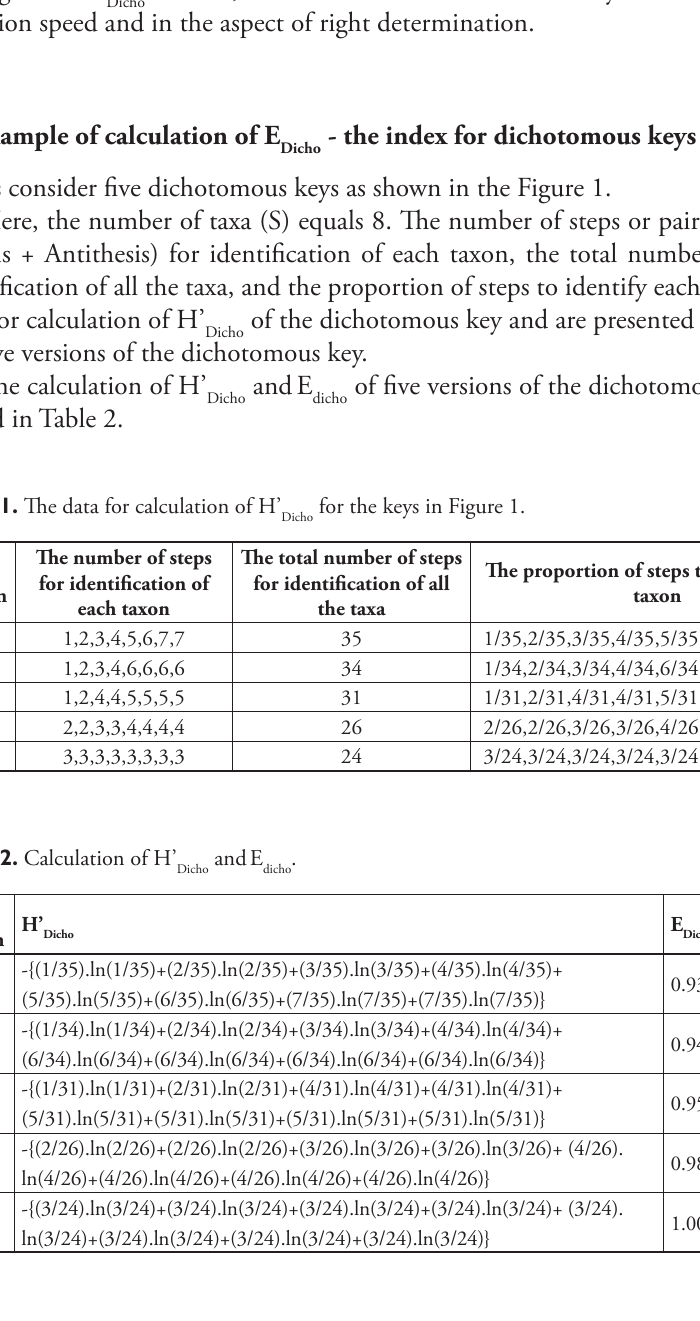
Table 1. The data for calculation of H’